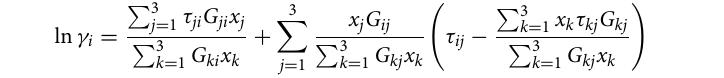
where G ij = exp ( − α ij τ ij ) , α ij = α ji and τ ij = τ ji = 0 . The UNIQUAC model, contains two different parts, including combinational and residual. This model is not fully thermodynamically consistent due to its two liquid mixture approach. In this approach the local concentra- tion around one central molecule is assumed to be independent from the local composition around another type of molecule. These parameters always are greater than zero.